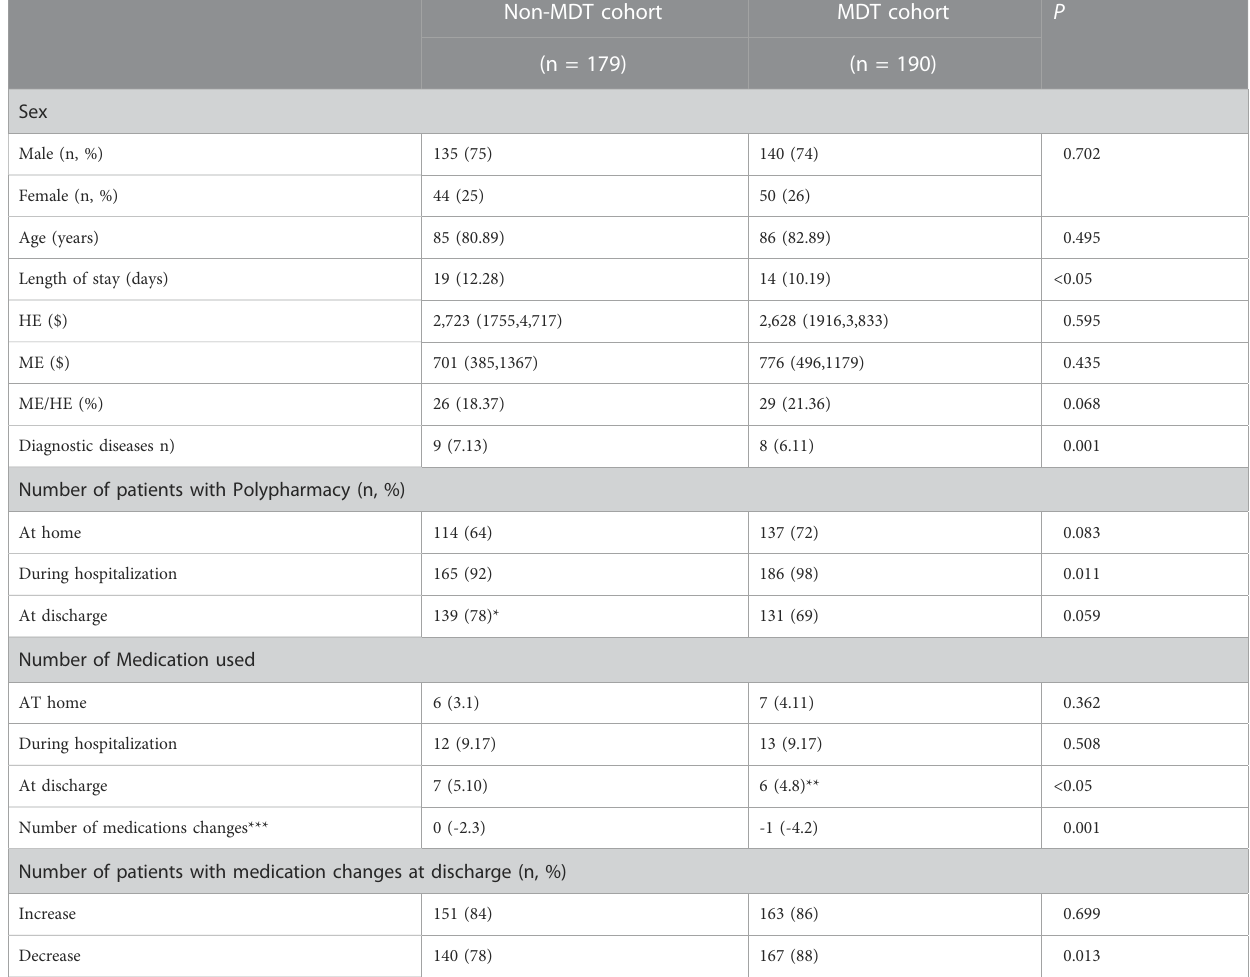
TABLE 1 Comparison of older inpatients ’ characteristics and medication change between the MDT cohort and the non-MDT cohort. Non-MDT